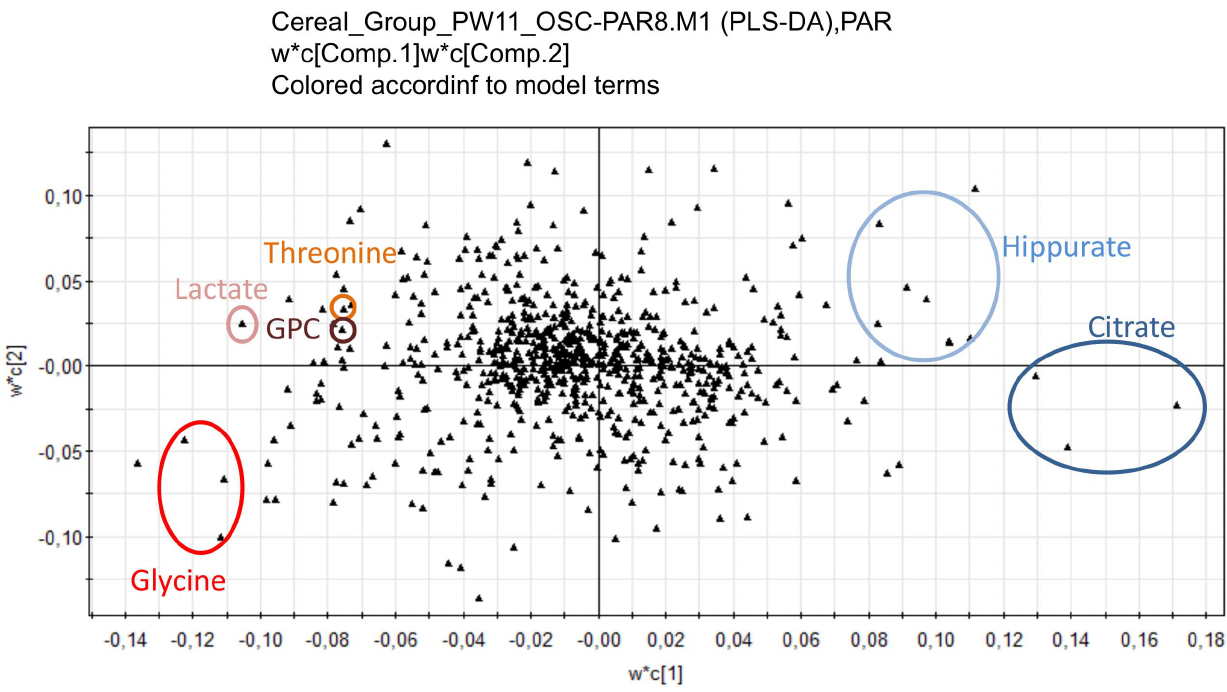
Figure 3. Graphical summary of the correlation between X and Y for the first two components. The correlation between X and Y (w*c) is represented by the loading plot. The PLS-DA model used was constructed on OSC-filtered and Pareto scaled data (N=83; R2=90.7% and Q2=0.53), from the 1 H NMR urinary metabolic profiles from 83 pregnant women differently exposed to pesticides.